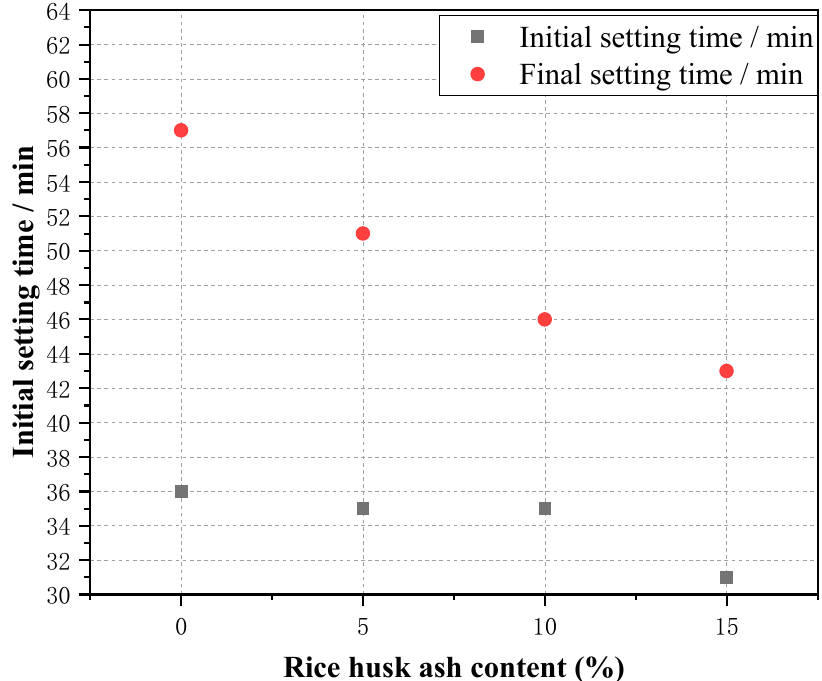
Figure 4. Setting time of purified slurry.